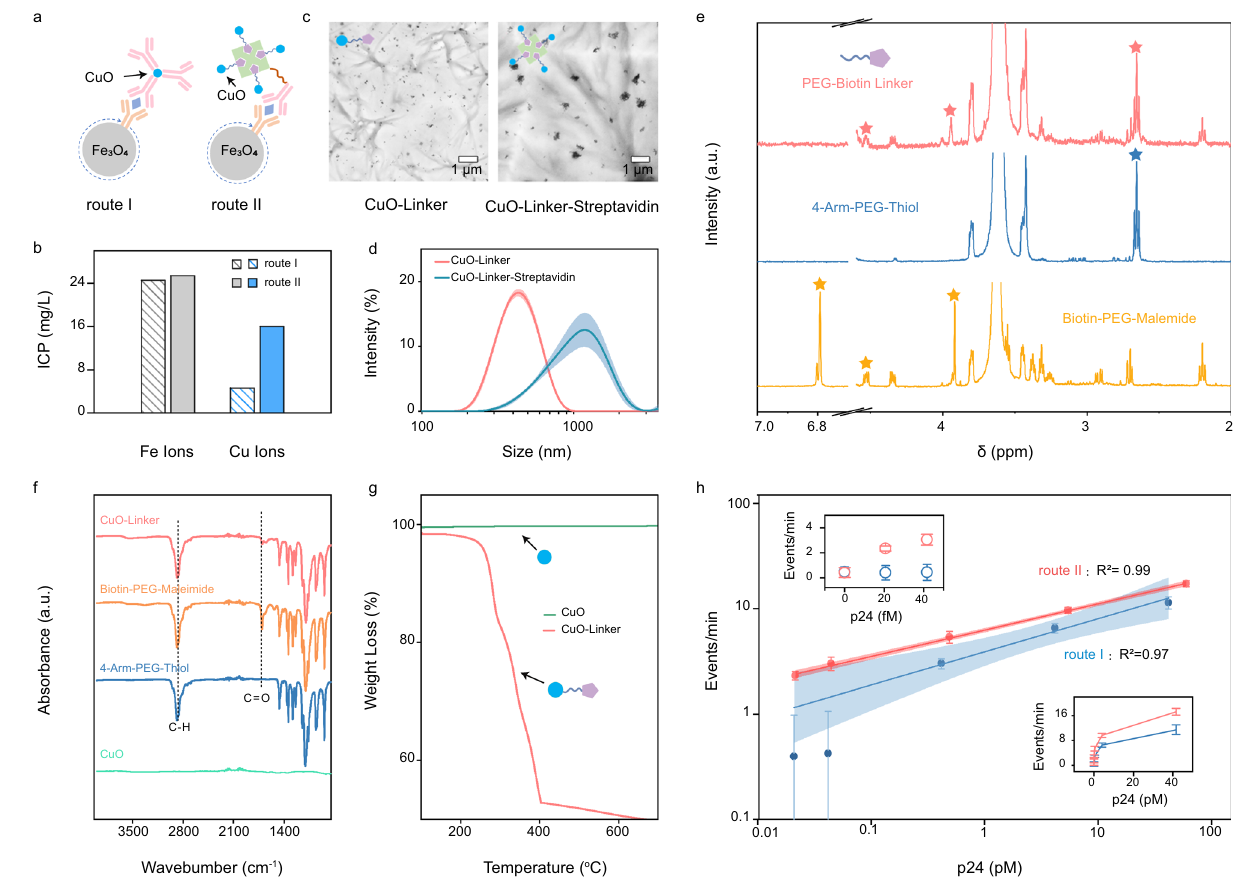
Fig. 4 | Assay optimization and analytical performance. a Schematic illustration of two sandwich structures obtained for assays with the traditional route (I): MBs- p24-CuO sandwich structures and the ampli fi ed route (II): MBs-p24-CuO sandwich structures with biotin-avidin ampli fi cation. b Corresponding ICP-OES results of Cu andFeionsofbothsandwichstructuresafteracidtreatment. c RepresentativeTEM images ( n =3 independent replicates were conducted with similar results) of CuONP-Linker and CuONP-Linker-Streptavidin structures. d Hydrodynamic size distribution pro fi les of CuONP-Linker and CuONP-Linker-Streptavidin structures. Data represents mean±SD of replicates ( n =3 biologically independent samples. Shadows indicate error bands. e 1 H NMR (400MHz) spectra of reactants (middle andlower)andachievedPEGlinkers(upper). f FTIRspectraofbareCuONPs,Linker, and CuONP-Linker structures. g thermogravimetric curves of bare CuONPs and